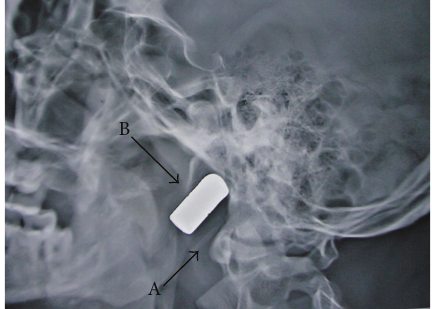
Figure 2: Preoperative X-ray of the skull, lateral view, showing the bullet (B) in the left parapharyngeal space at the level of the atlas (A).